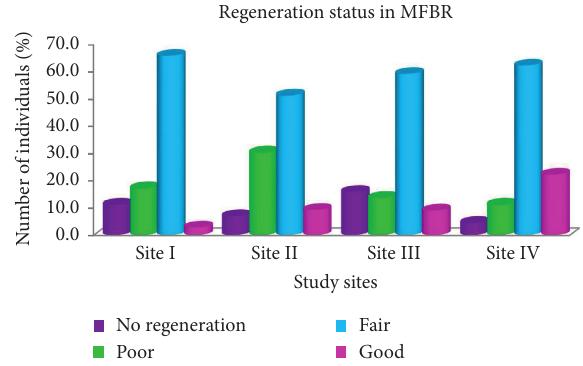
Figure 11: Regeneration status of woody species in